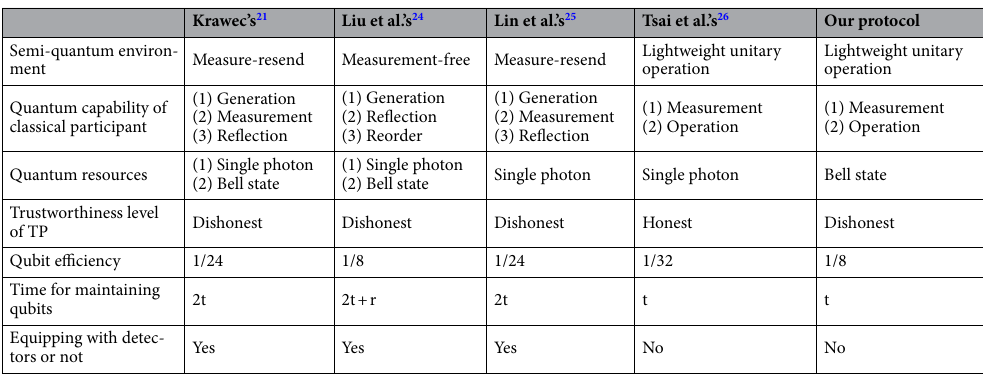
Table 5. Comparison to the existing MSQKD